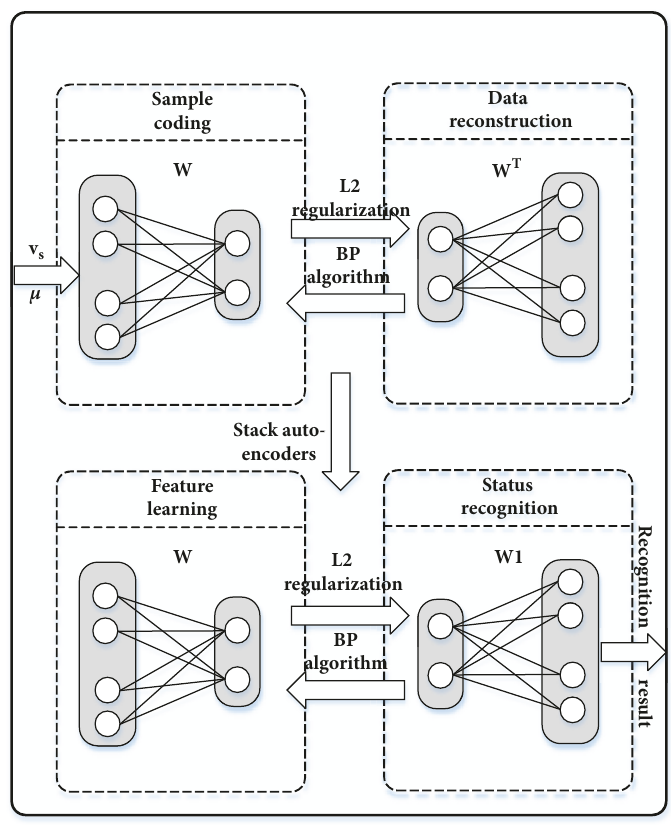
Figure 4: Flowchart of deep neural network algorithm.